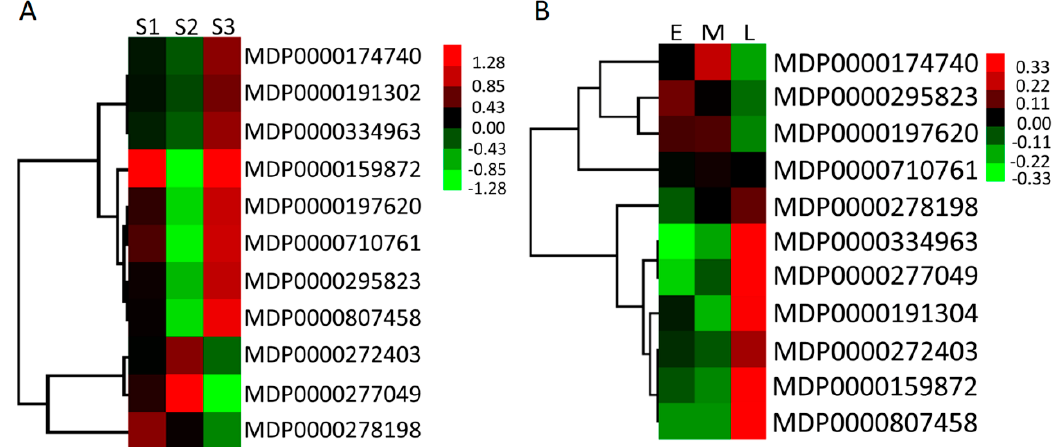
Figure 6. Expression level of MdMDH genes during apple fruit development ( A ) and flower bud differentiation ( B ) of apple cultivar “Qinguan”. The heat map was generated by Mev software based on RNA-seq database, and normalized log2 transformed values were used with hierarchical clustering. S1, S2 and S3 represent juvenile stage, expanding stage and mature stage of fruit development, respectively. E, M and L represent early stage, middle stage and late stage of flower bud differentiation, respectively.